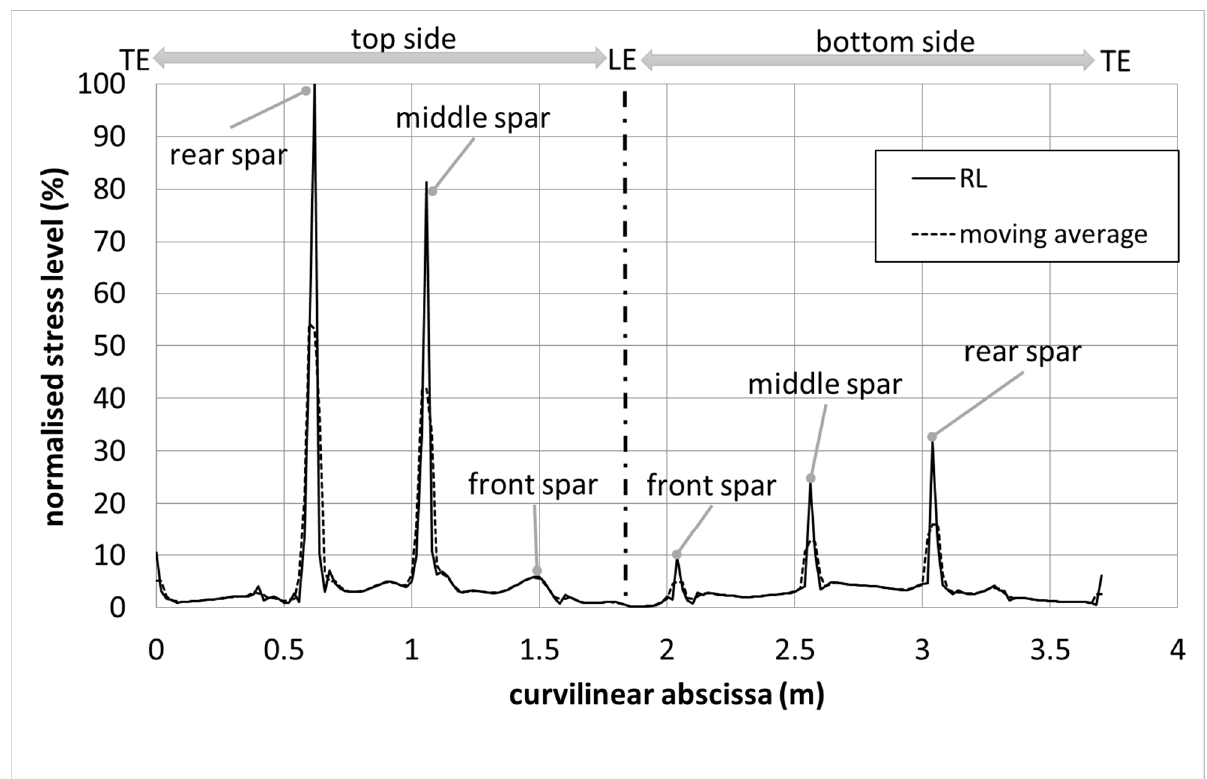
Figure 10. Normalized stress level vs. curvilinear abscissa of the winglet strip: original (solid) and after moving average (dashed); normalization reference: maximum stress computed on the distribution reported in Figure 4 (RL).